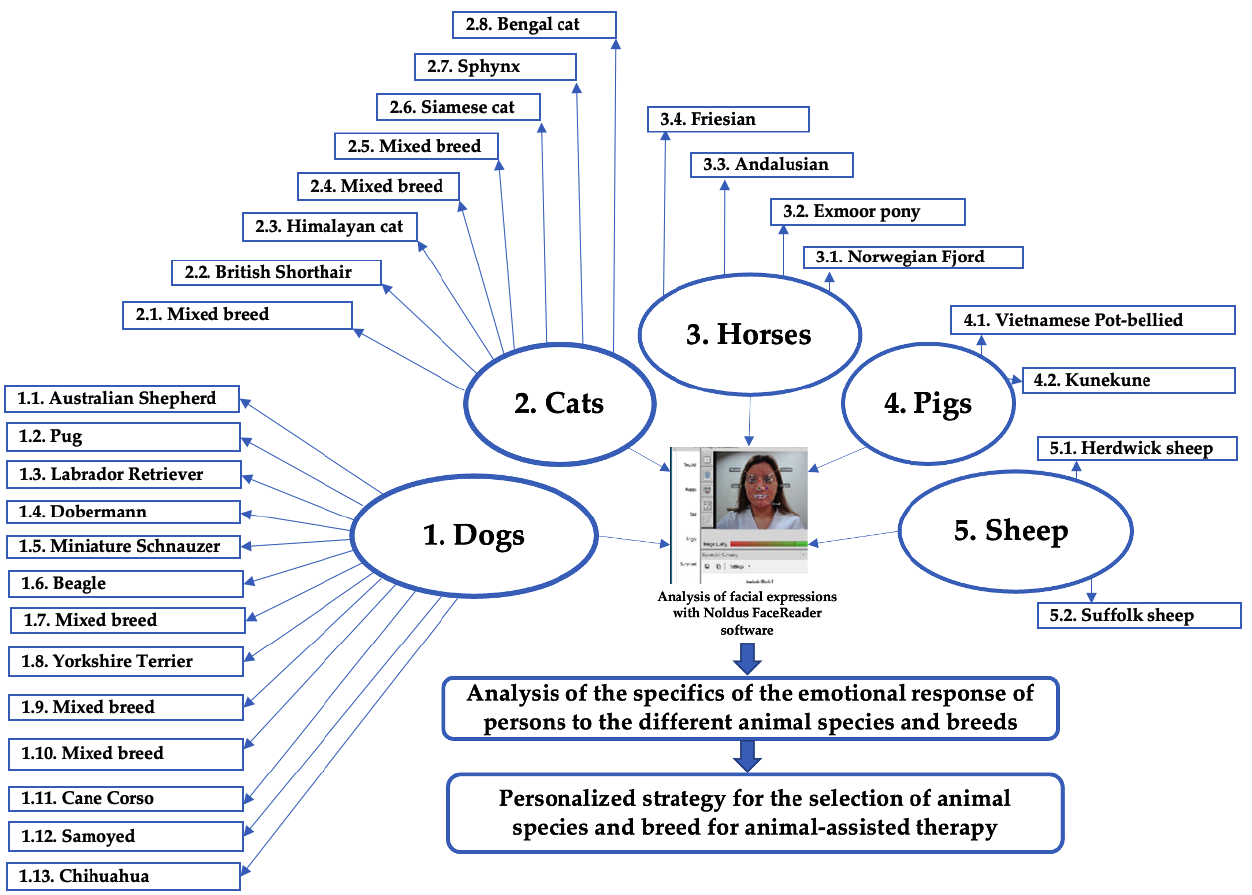
Figure 1. Principal scheme of the